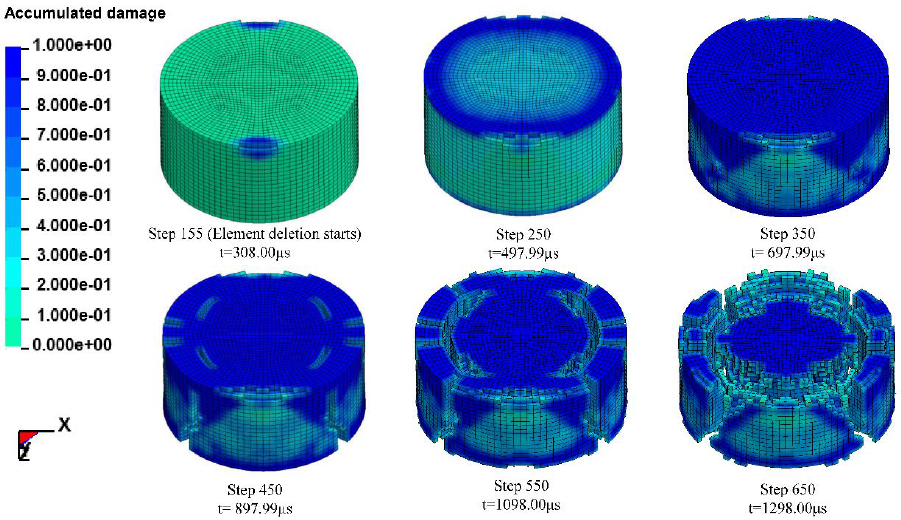
Figure 12. RCC specimen failure process and the accumulated damage.